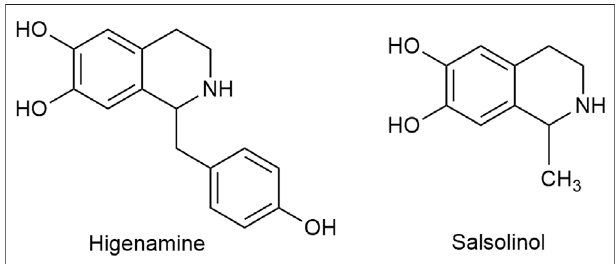
FIGURE 4 | Structures of higenamine and salsolinol in